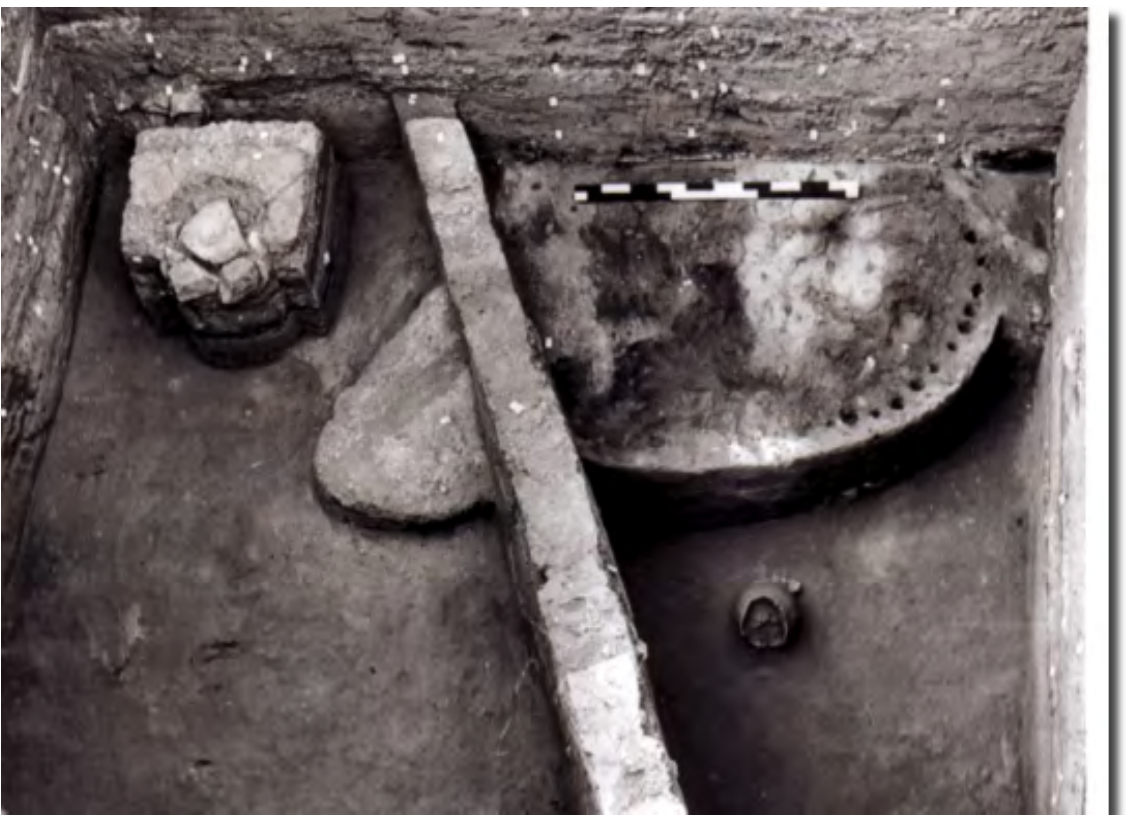
Figure 15. Excavation H5 on the Southern Terrace, showing an excavation witness section diagonally across the excavation; and remaining architectural remains of different layers left in situ , including a mortar stone in a stone-lined pit embedded in a gravel floor (to the rear left) in Layer 6(i), but probably belonging to Layer 5; a gravel patch in the middle; the remains of a medium-sized circular pole and daub structure (rear right) consisting of a compacted sand floor and a single row of wall post holes in a wall trench in Layer 6(iii); and a ceramic pot in a small pit in the sterile bottom deposit (Meyer 1998:157, Figure